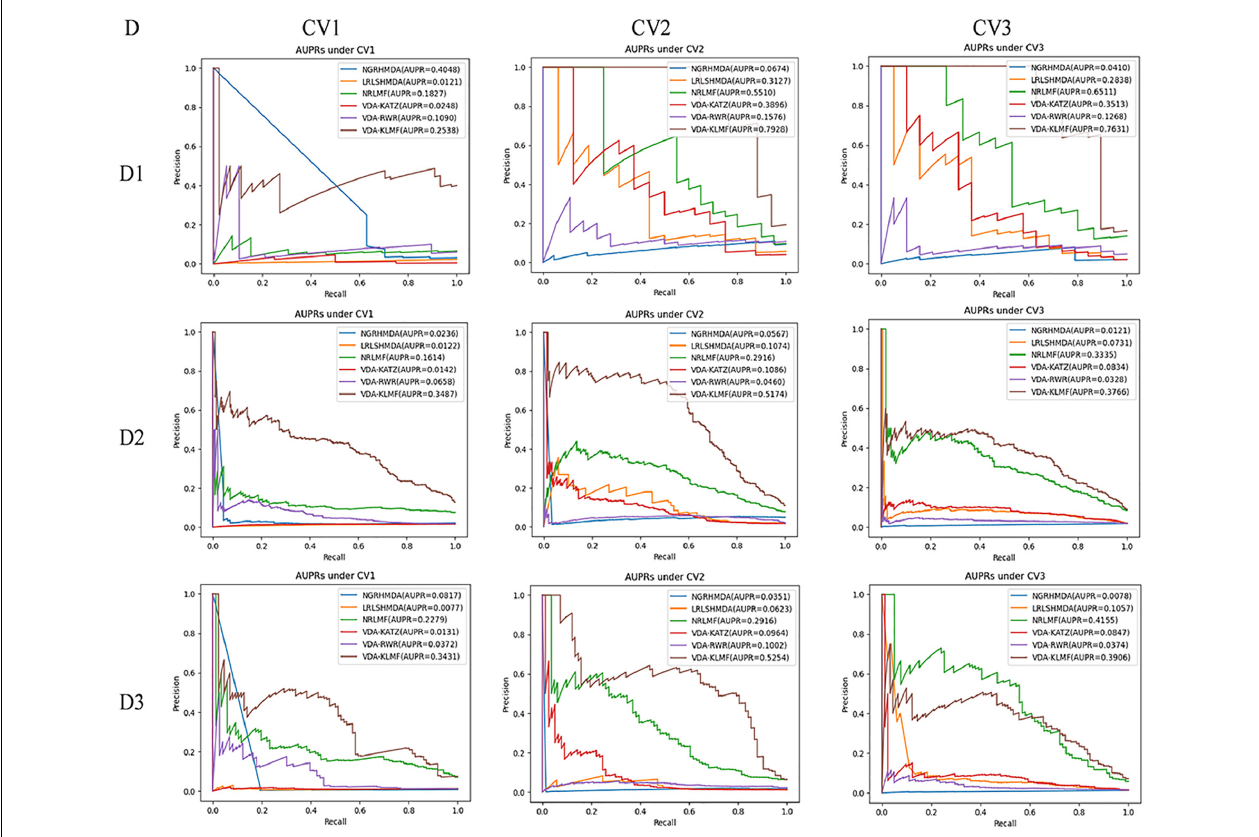
FIGURE 3 | The AUPR values predicted by six VDA prediction methods (D denotes dataset, DI denotes dataset 1, D2 denotes dataset 2, D3 denotes dataset 3).